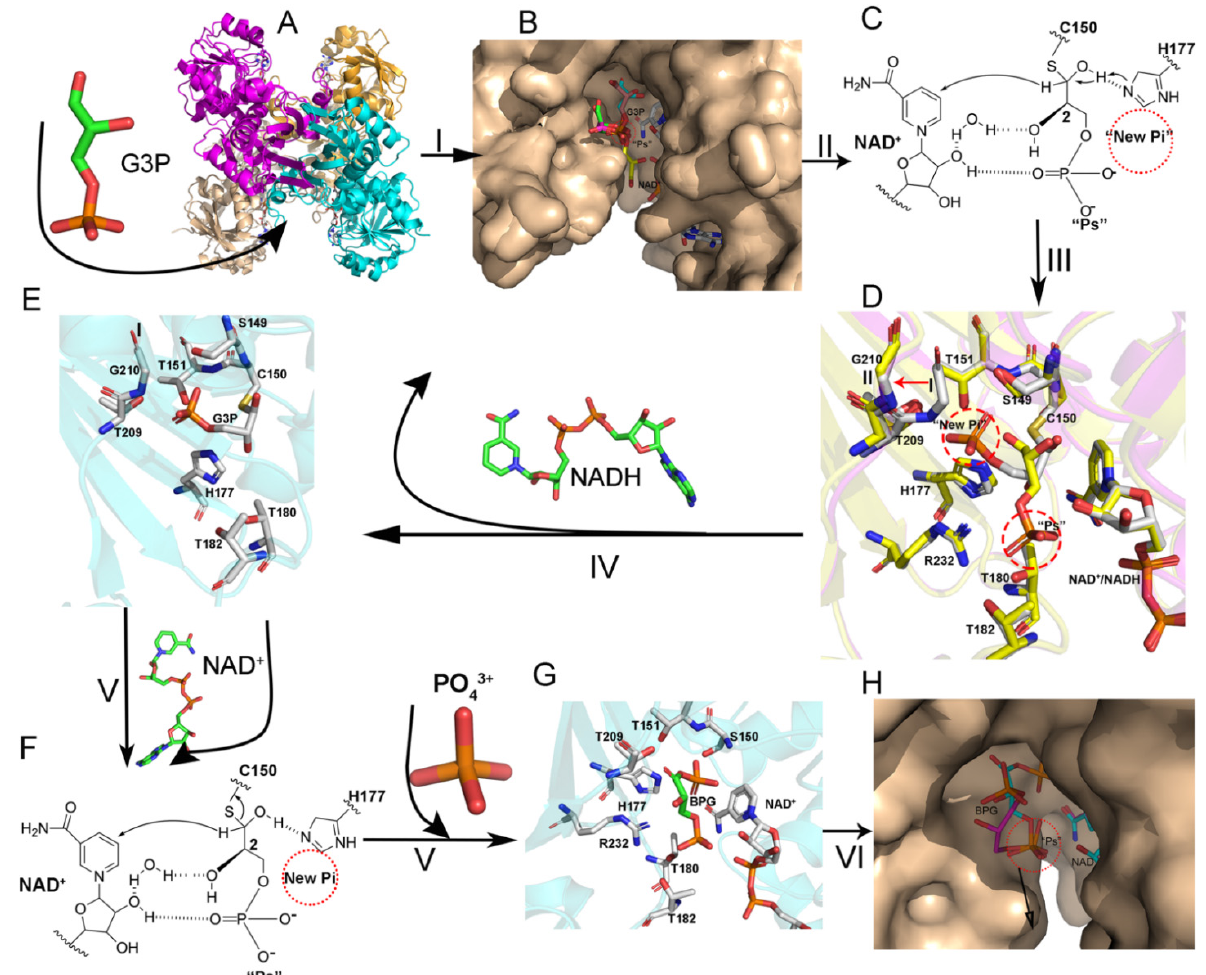
Figure 7. The catalytic process. Step I: G3P enters the catalytic domain. Step II: The thiol group of Cys150 executes a nucleophilic attack on the carbonyl carbon (C1) of D-G3P to form a hemithioacetal intermediate. Step III: Hydrate transfer. Step IV: Coenzyme exchange. Step V: Phosphorylation. Step VI: BPG release. ( A ) The overall structure of Ec GAPDH1. ( B ) Superimposition of the O subunit of WT.NAD.G3P (7C5P); the Q, O, and P subunits of C150A+H177A.NAD.G3P (7C5M); and the Q subunit of C150S.NAD.G3P on the P subunit of TmGAPDH (3K73). The subunit is depicted in a wheat-like color, whereas G3P is depicted as sticks. ( C ) Hemithioacetal intermediate. ( D ) Superposition of amino acids interacting with G3P of the Q subunit of the thioacyl complex with the P subunit of C151S.NAD.G3P. The thioacyl complex is shown in magenta, while C151S.NAD.G3P is shown in yellow. ( E ) The R subunit is depicted in cyan of the thioacyl intermediate (7C7K). ( F ) New NAD+ enters the catalytic domain. ( G ) BPG interacts with amino acids and NAD + in the O subunit of C150S.NAD.BPG. ( H ) Superimposition of BPG (cyan) from the O subunit of C150S.NAD.BPG and BPG (magenta) from